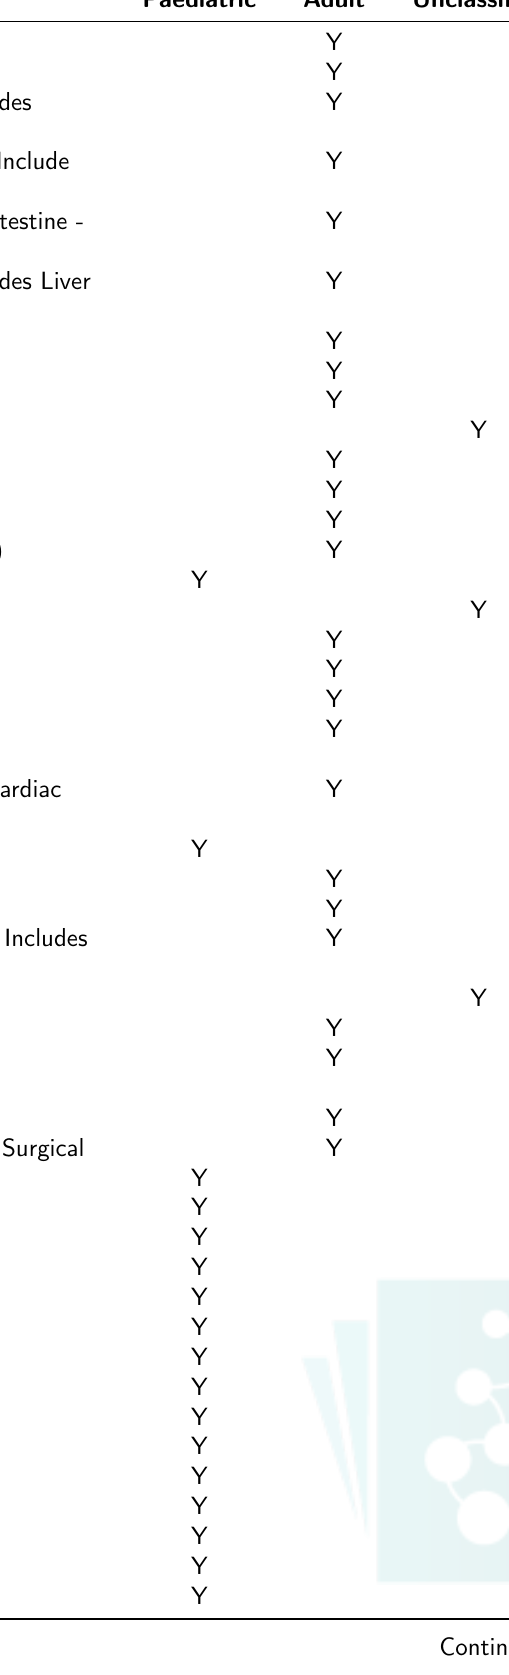
Supplementary table 1: Classification of treatment specialties as paediatric, adult or unclassified Treatment